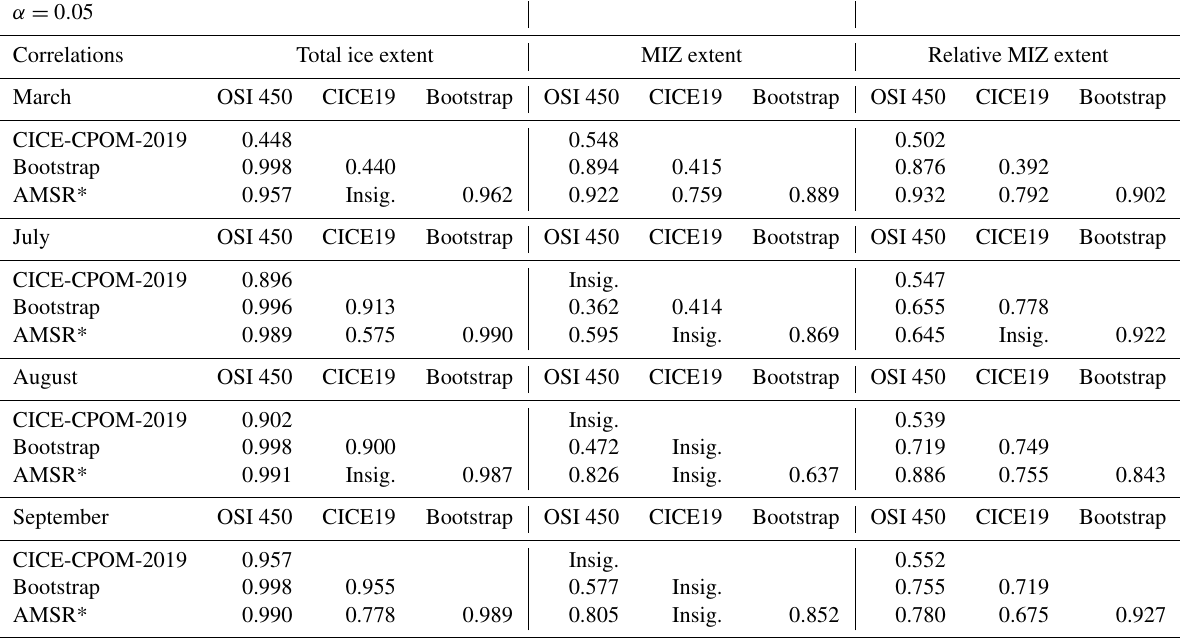
Table 2. Correlations of the interannual variability for the total sea ice extent, MIZ extent, and extent of the MIZ relative to the total sea ice extent for the model run and all observational datasets